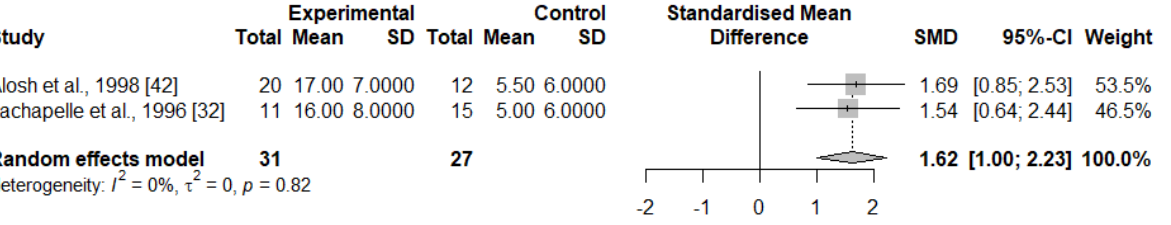
Figure 3. Random-effect meta-analysis for the levels of endometrial B cells in IRPL and HC women.